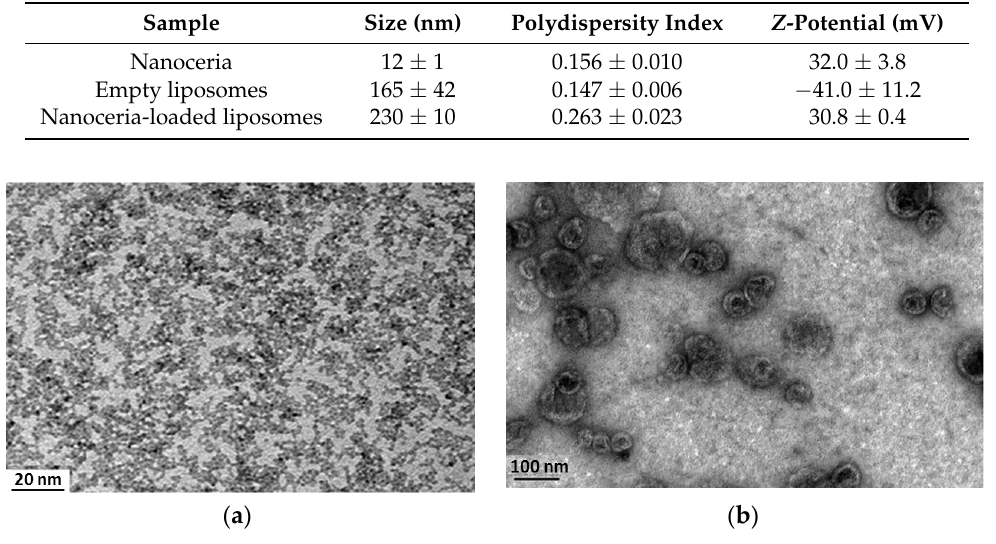
Figure 1. TEM imaging of free nanoceria ( a ) and of nanoceria ‐ loaded liposomes ( b ).